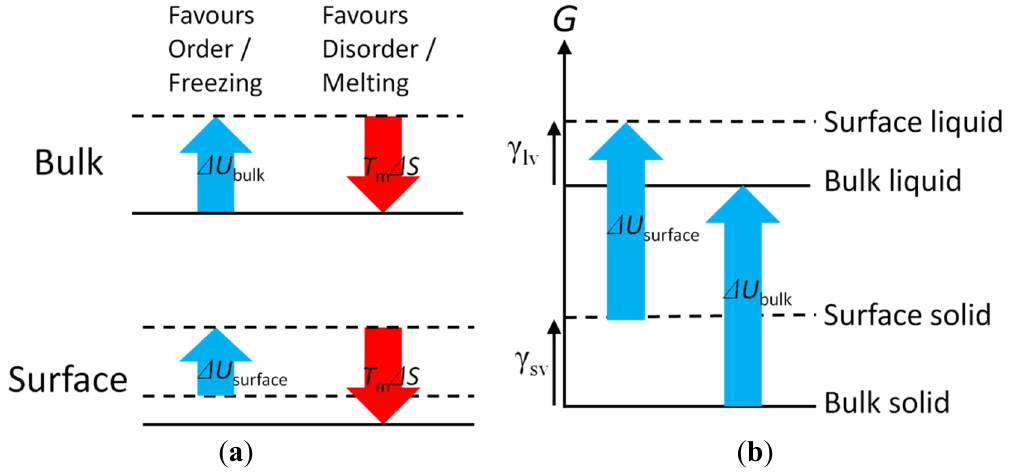
Figure 1. Schematic illustration of free energy balance upon ( a ) freezing/melting and ( b ) surface vs. bulk of a